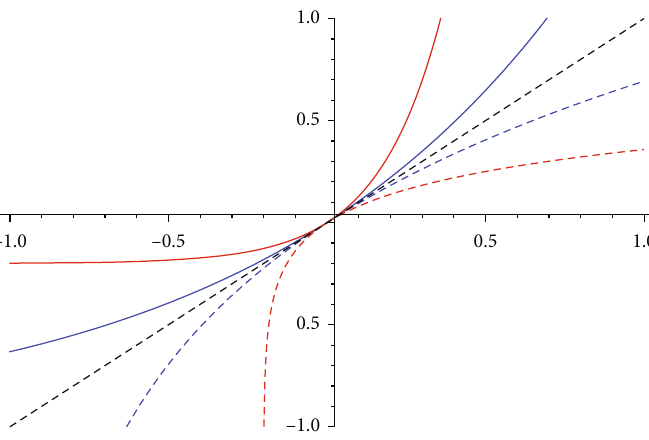
Figure 1: The graphs of u ð x Þ = 1/ μ ð e μ x − 1 Þ (solid), x ð u Þ = 1/ μ ln ð μ u + 1 Þ (dashed), blue for μ = 1, and red for μ = 5 .